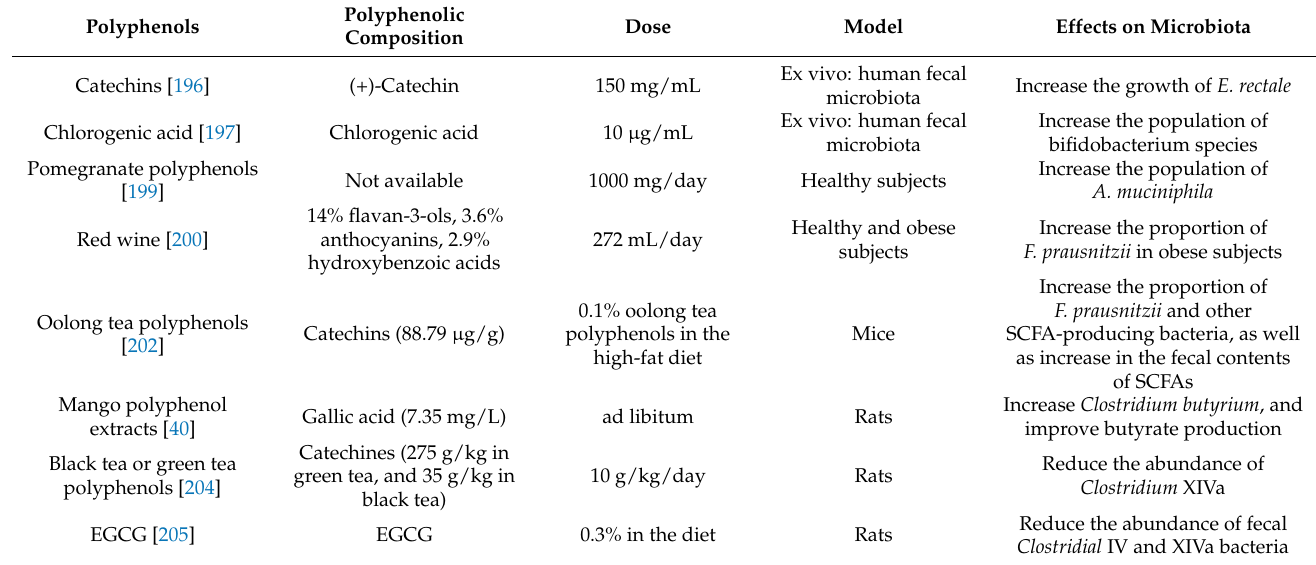
Table 2. Polyphenols regulates short chain fatty acid (SCFA)-producing